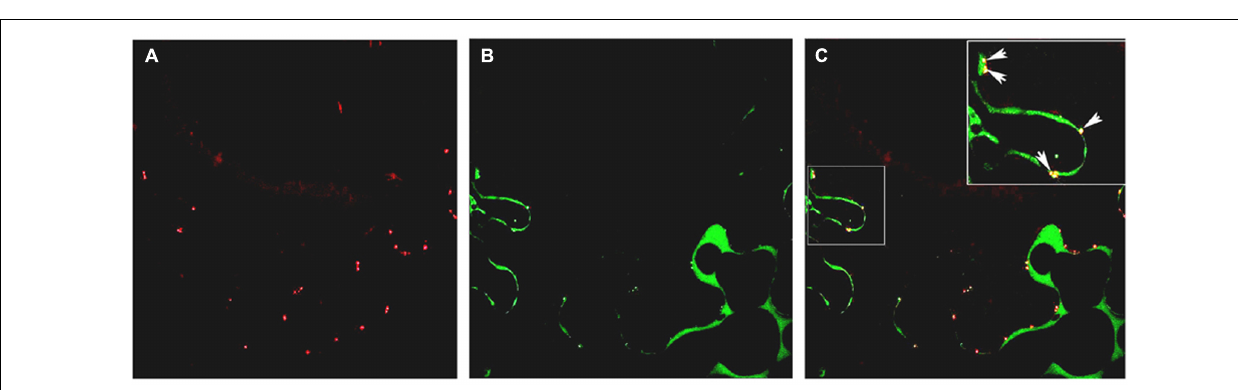
FIGURE 2 | Subcellular localization of PsEND1 in Nicotiana benthamiana leaves as observed by confocal microscopy. (A) Plasmodesmata stained by aniline blue (red). (B) Localization of PsEND1 fused to YFP (green). (C) Co-localization of plasmodesmata and PsEND1. The yellow dots indicate the co-localization of both fluorescent